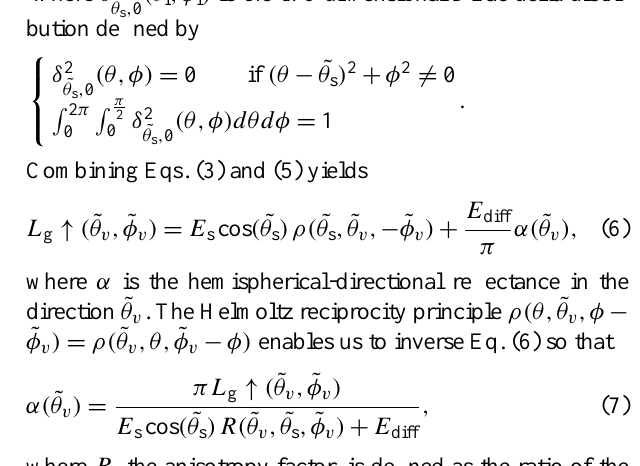
Fig. 2. Radiance components. (1) Target radiance L g ↑ , (2) path radiance L p , (3) background radiance L k , direct solar irradiance E s , diffuse solar irradiance E d , (4) diffuse environmental irradi- ance E m , (5) reflected terrain irradiance E t . Adapted from Sirguey